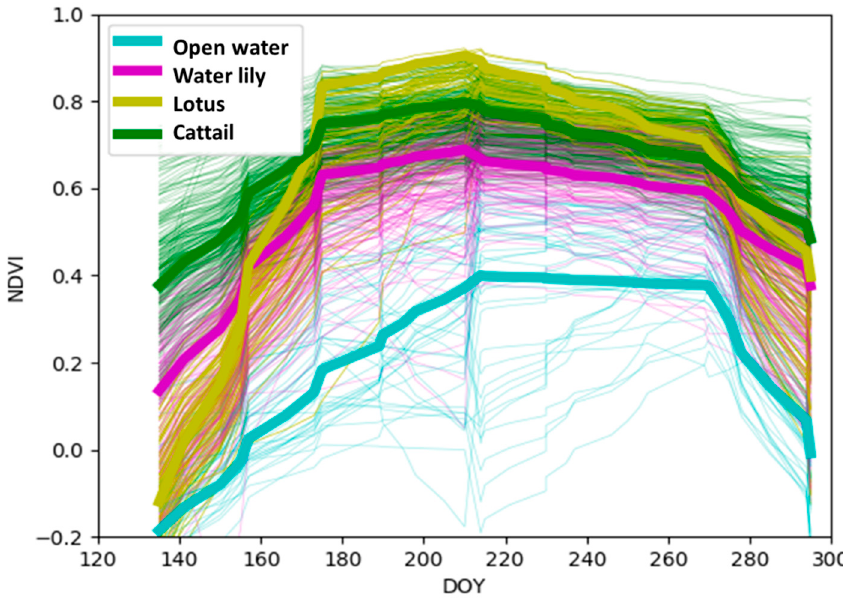
Figure 3. NDVI time series calculated from “pure” pixels in the HLS dataset of 2017. Results for individual pixels are shown in a thin line, and the mean is marked with a think line. The means were used as standards to classify the HLS pixels in other years.